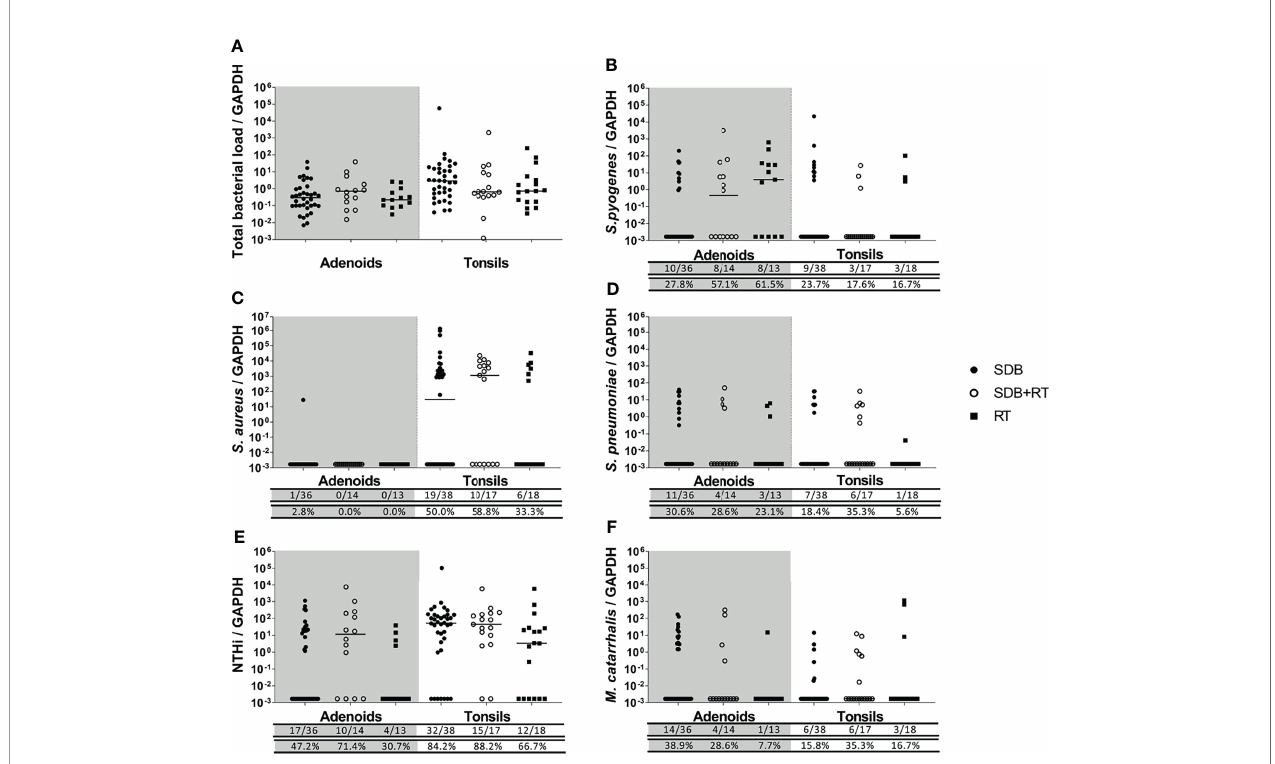
FIGURE 2 | Total bacterial load (A) and speci fi c bacterial density (B – F) in adenoids and tonsils from children with SDB ( (cid:129) ), SDB+RT ( ⚬ ), RT ( ▪ ). Numbers underneath each graph represent the number of children in each group considered positive for each bacterial species ( top row) and the corresponding proportion (bottom row). Samples not available: 4 adenoids from children with SDB, 3 adenoids from children with SDB+RT and 5 adenoids from children with RT; 2 tonsils from children with